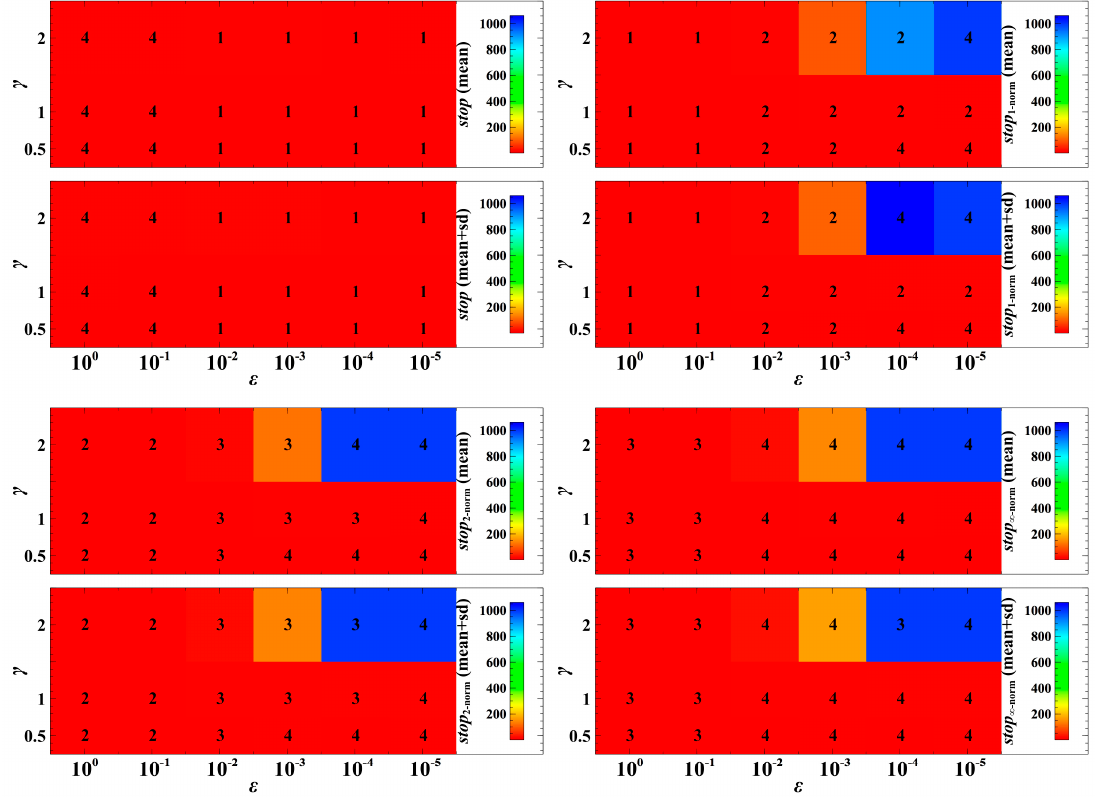
Figure 2. Convergence time to the evolutionary objective under the deterministic case. In this figure, ‘stop’ means time of convergence towards the evolutionary objective for non-cooperative optimization, and ‘stop’ with the index means time of convergence towards the evolutionary objective using the corresponding mathematical norm. The larger the ε , the larger the effect of the distance metric to the trait dynamics in one generation. Here, we consider γ = 0.5, which means β i is half of α i , γ = 1, which means β i equals α i , and γ = 2, which means β i is double α i . The numerals 1 to 4 represent the ranking of convergence, where 1 denotes the fastest convergence while 4 denotes the slowest convergence. We took the mean and the mean plus standard deviation (sd) of 1000 numerical simulations with random population initial conditions.